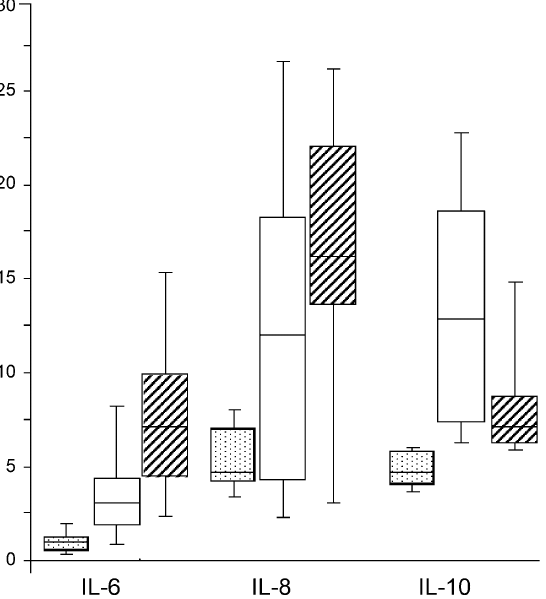
FIG. 1. Circulating cytokine levels from patients with ANCA- associated vasculitis, separated according to disease activity. , results from patients in remission; , results from patients with grumbling disease; , patients with minor relapse; , patients with major relapse; , healthy control group. *, **, ***Significant p values, relative to controls (p B / 0.05, p B / 0.01, p B / 0.001, respectively) when using the Mann (cid:1) / Whitney